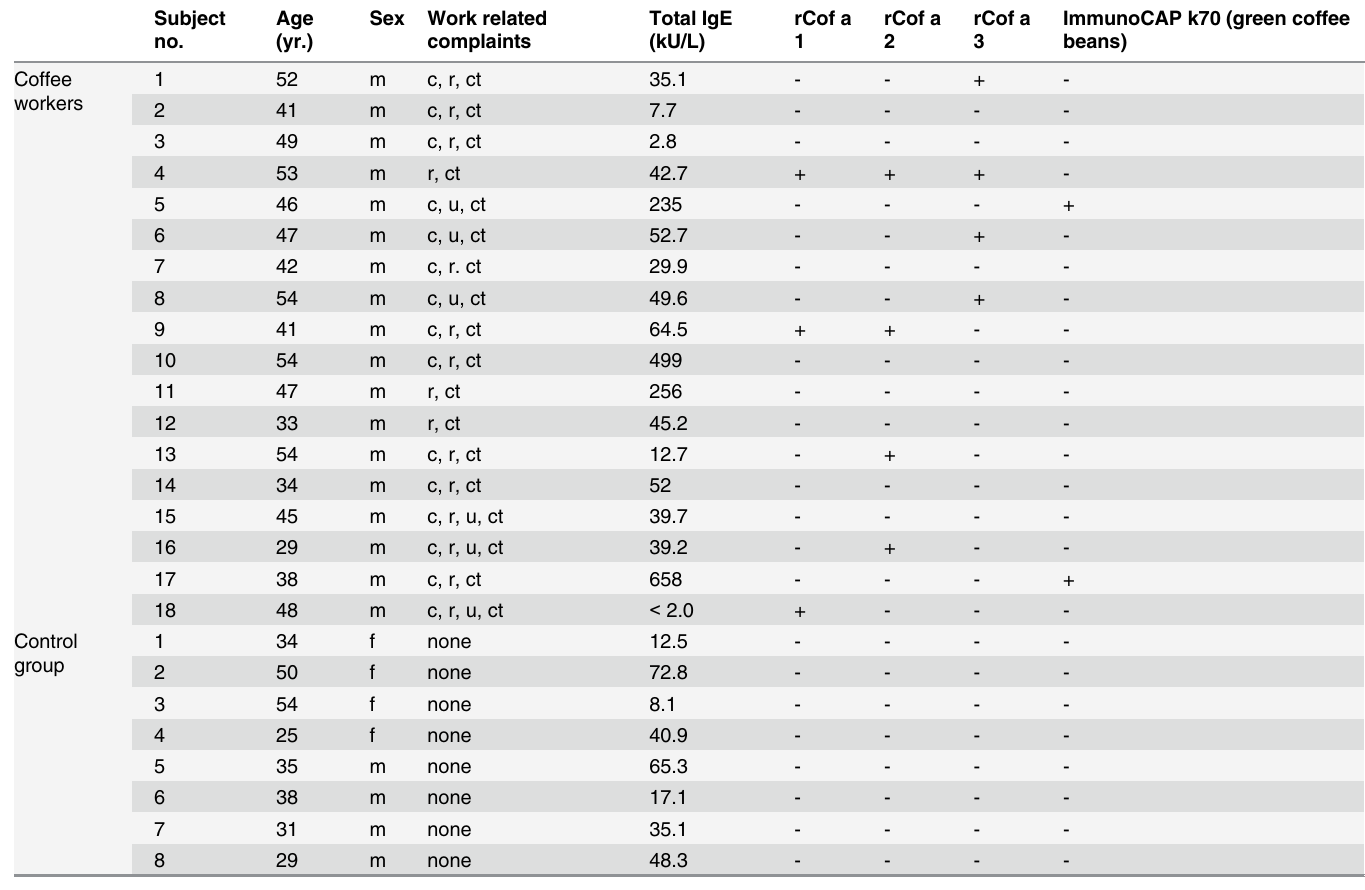
Table 1. Clinical details of the study population and reactions to tested allergens. Subject Age no.